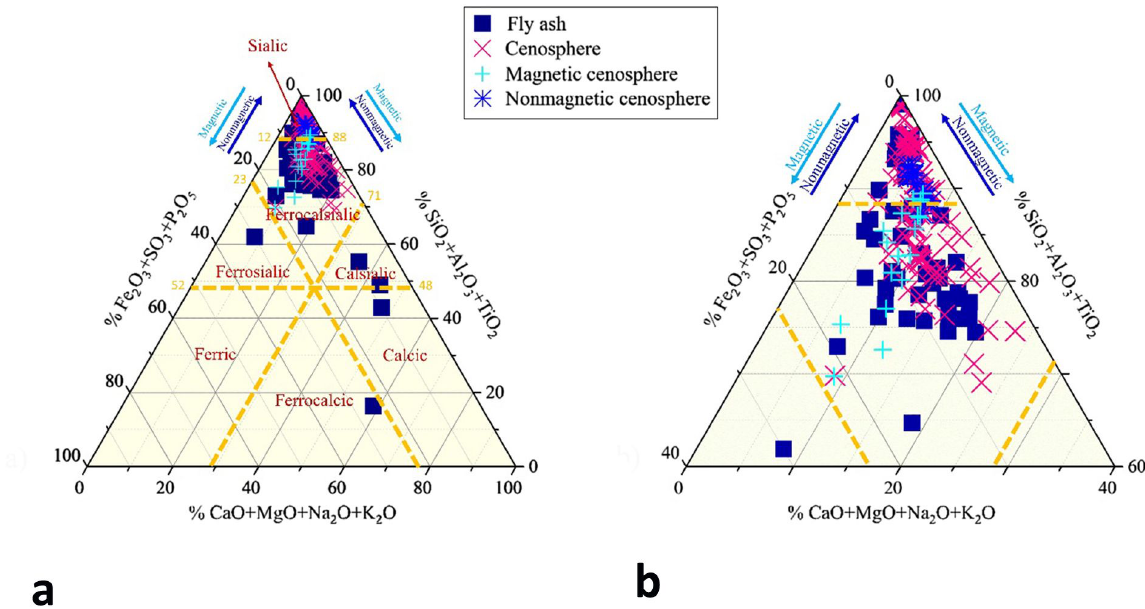
Figure 1: The ternary diagaram of chemical composition of selected fly ashes and cenosphers prepared by Ranjbar and Kenzel [1], a) full diagram, b) magnification of the cenosphers forming area – sialic and ferrcalcsialic